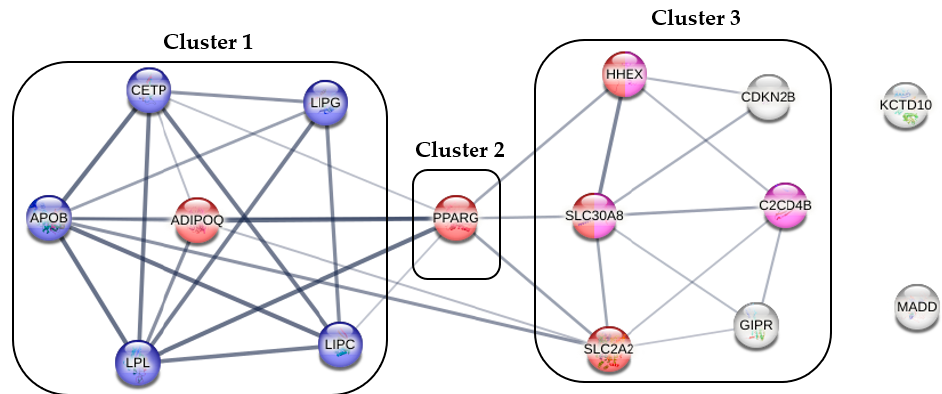
Figure 2. Gene–gene interaction and cluster analysis results based on genes containing SNPs selected during the genetic risk score optimization process. Note: genes associated with lipid metabolism are highlighted in blue, with diabetes in general in red, and with gestational diabetes in pink. The thickness of the lines connecting genes indicates the strength of the association between them.